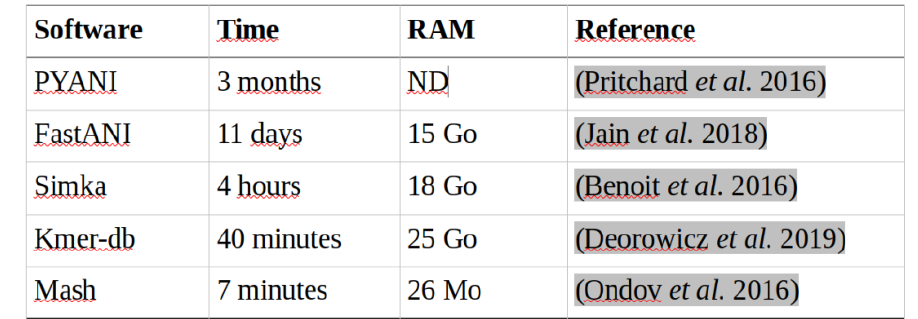
Table 1. Comparison of softwares that estimate genome